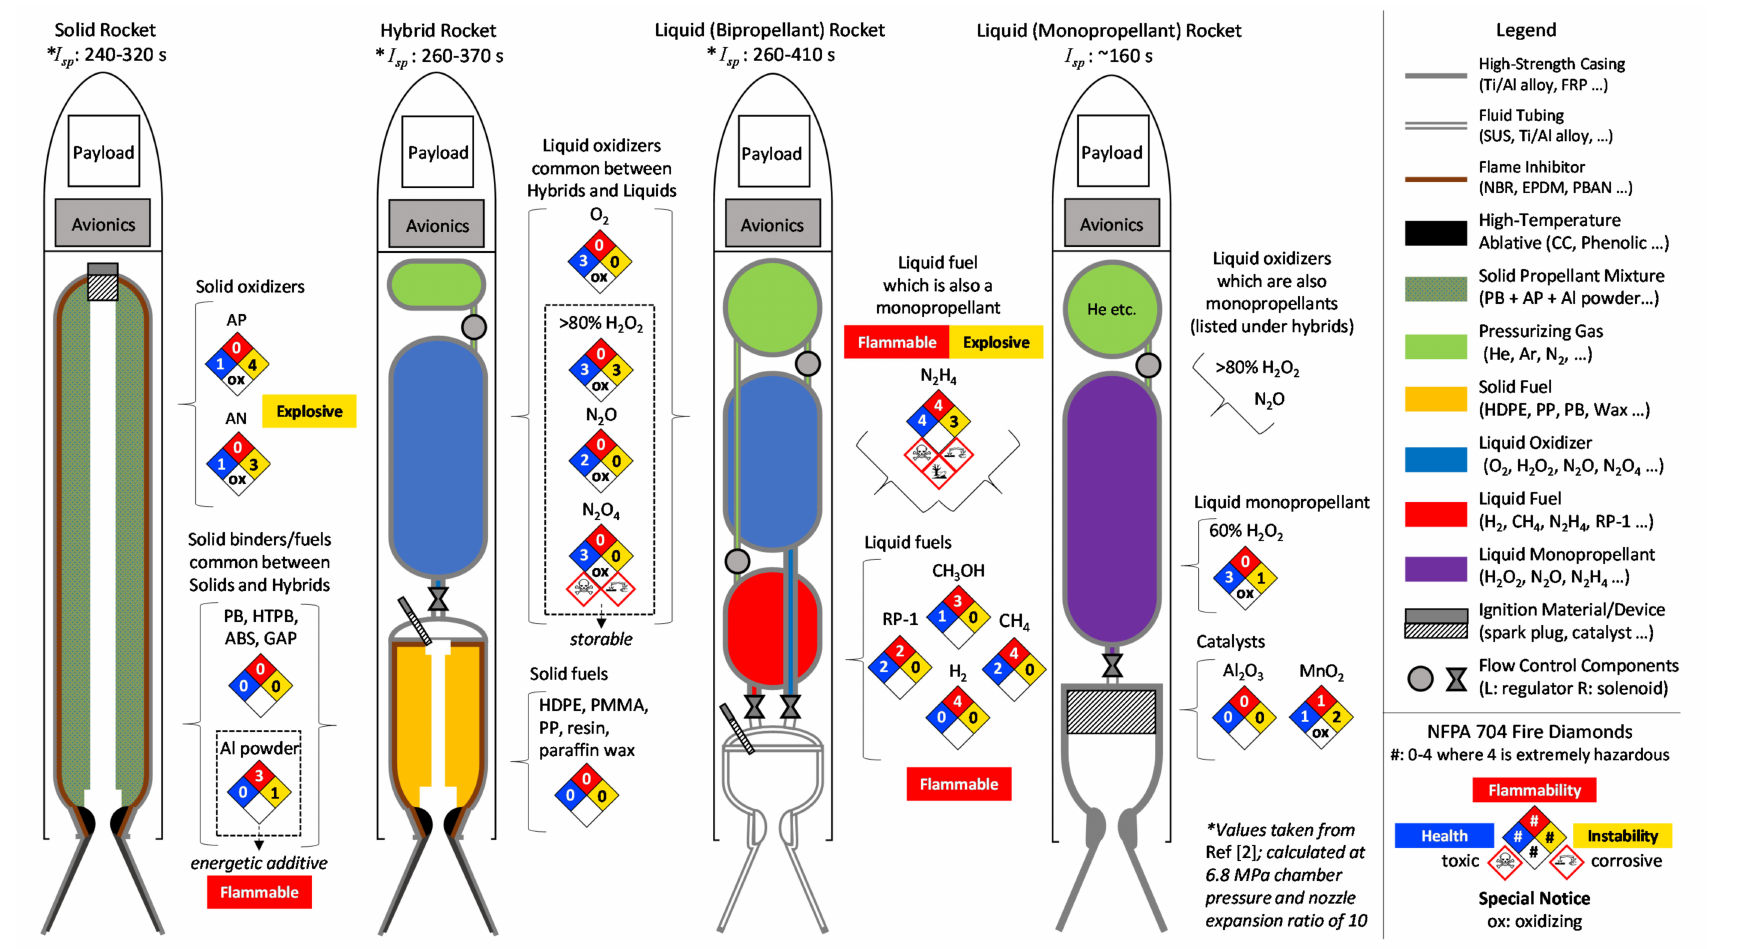
Figure A1. Comparison of Chemical Rocket